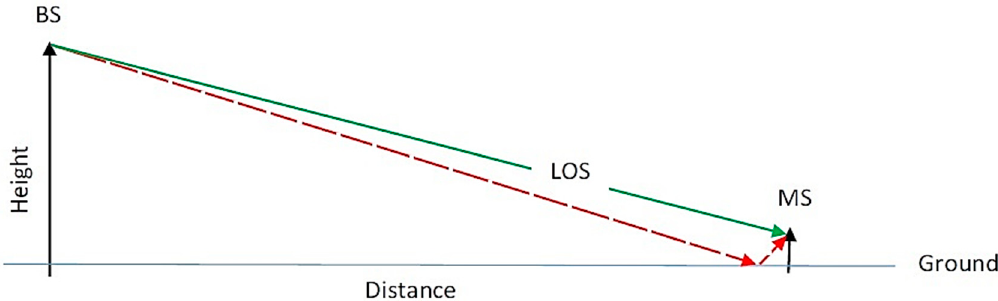
Figure 3. Ground reflected multipath (red dashed path).